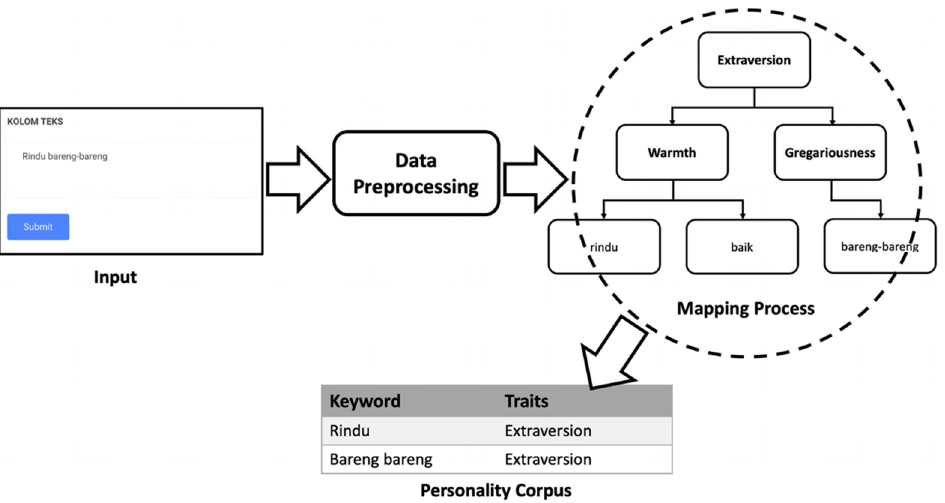
Figure 4. Personality Measurement